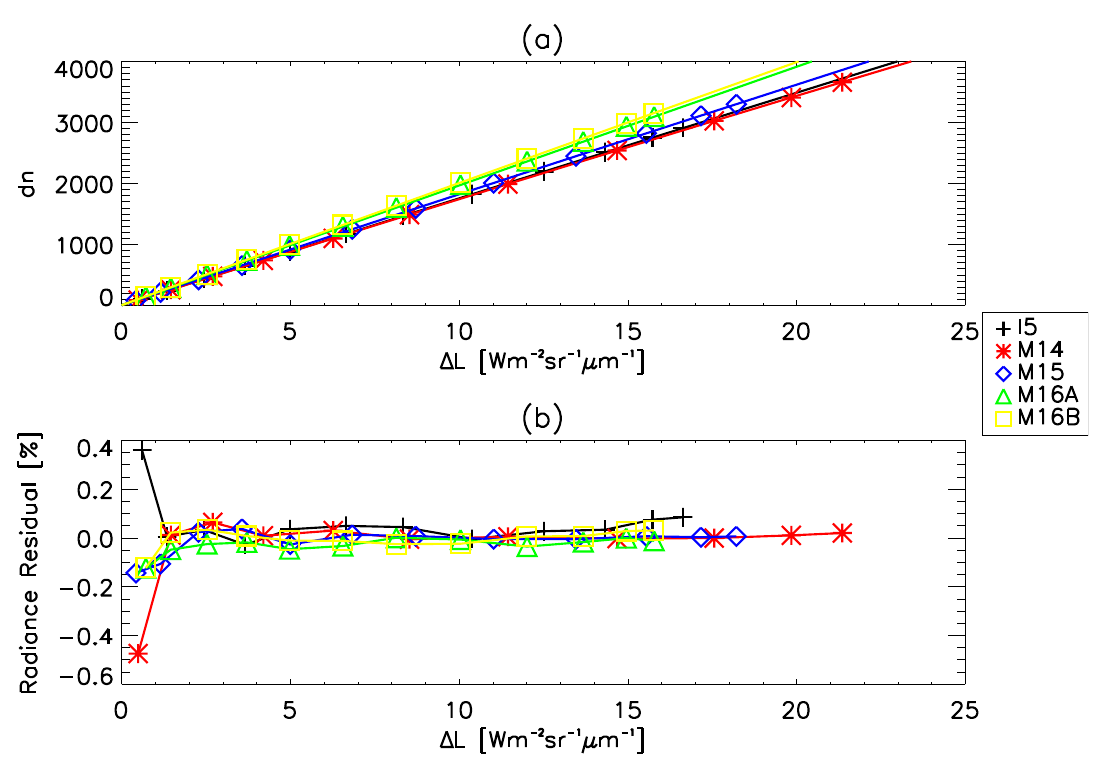
Figure 3. The offset corrected detector response ( a ) and the radiance residual in % ( b ) shown versus path difference radiance. The symbols in ( a ) represent measured data and the lines indicate quadratic fits. The measured data was taken from nominal plateau, HAM side A, electronics side A, FPA temperature 80.5 K using detector 9 (BCS